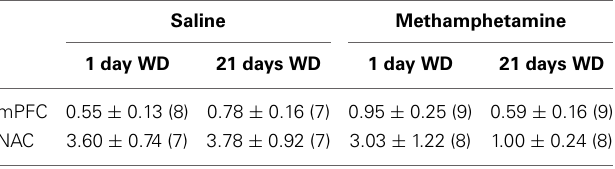
The data represent the mean ± s.e.m. of the number of animals indicated in